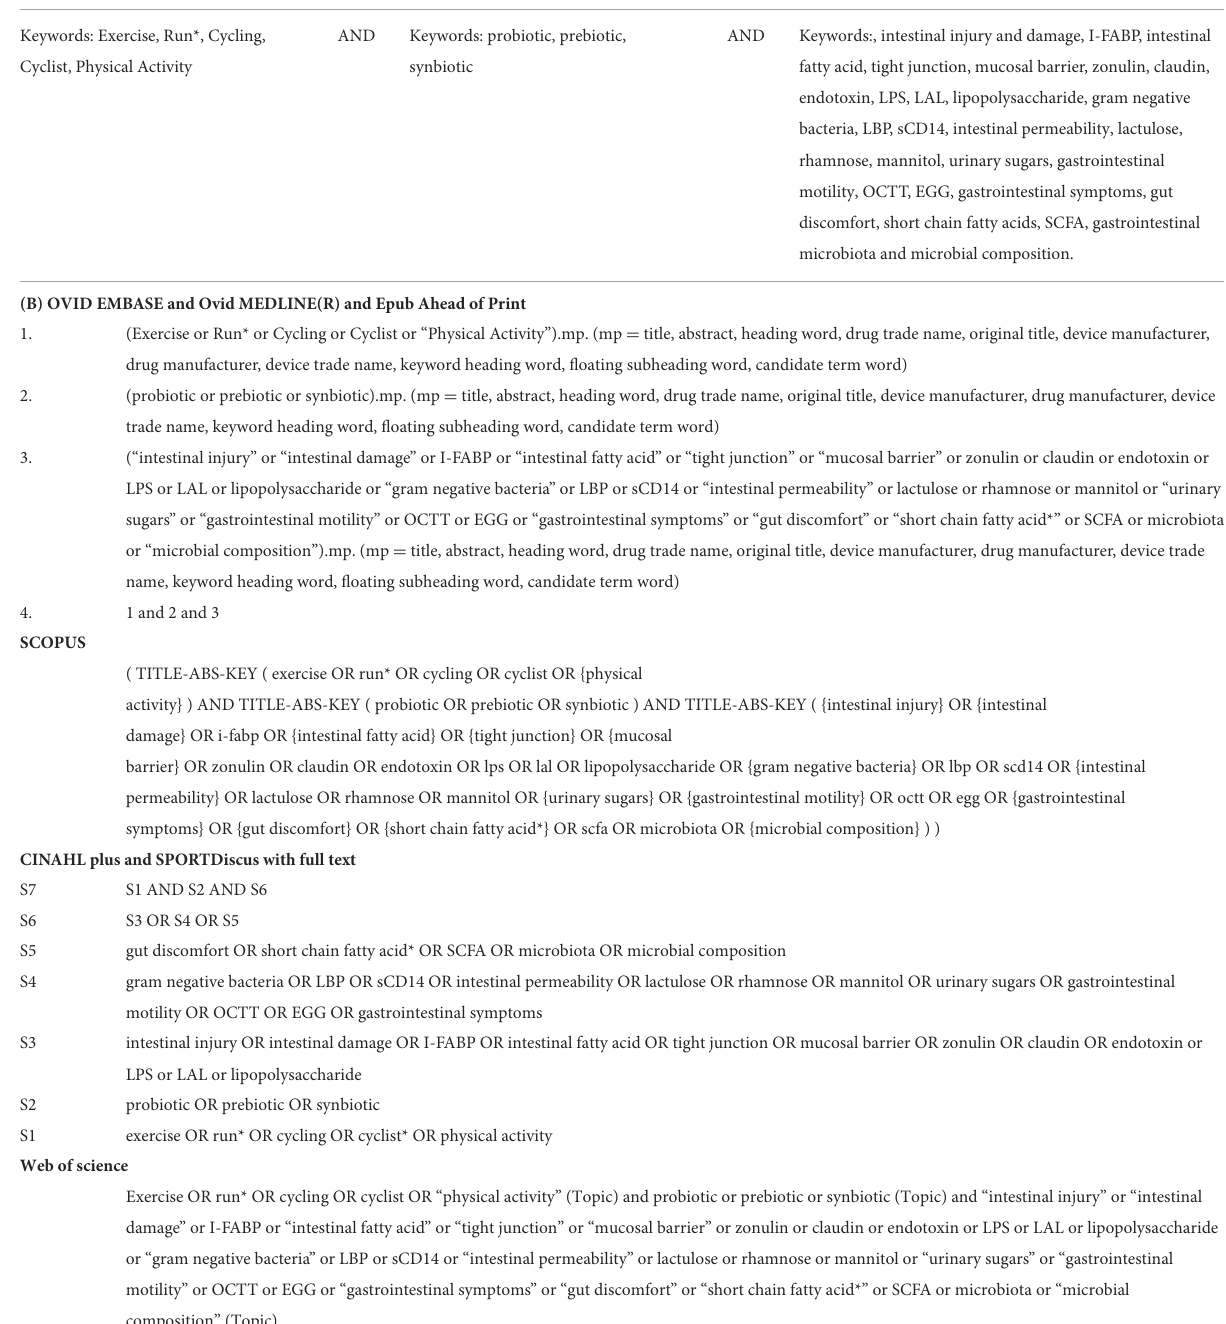
TABLE 1 General search strategy (A) and search strategy logic by database (B) for the systematic review on the effect of pre-, pro-, and synbiotics on gastrointestinal outcomes in healthy adults and healthy active adults. (A) Field one (combine with Field two (combine with OR): Field three (combine with OR): Outcome OR): Population Intervention and comparison AND Keywords: probiotic, prebiotic, AND Keywords:, intestinal injury and damage, I-FABP, intestinal synbiotic fatty acid, tight junction, mucosal barrier, zonulin, claudin, endotoxin, LPS, LAL, lipopolysaccharide, gram negative bacteria, LBP, sCD14, intestinal permeability, lactulose, rhamnose, mannitol, urinary sugars, gastrointestinal motility, OCTT, EGG, gastrointestinal symptoms, gut discomfort, short chain fatty acids, SCFA, gastrointestinal microbiota and microbial